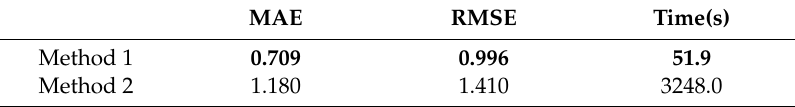
Table 9. Performance comparisons between using and without using user comments.